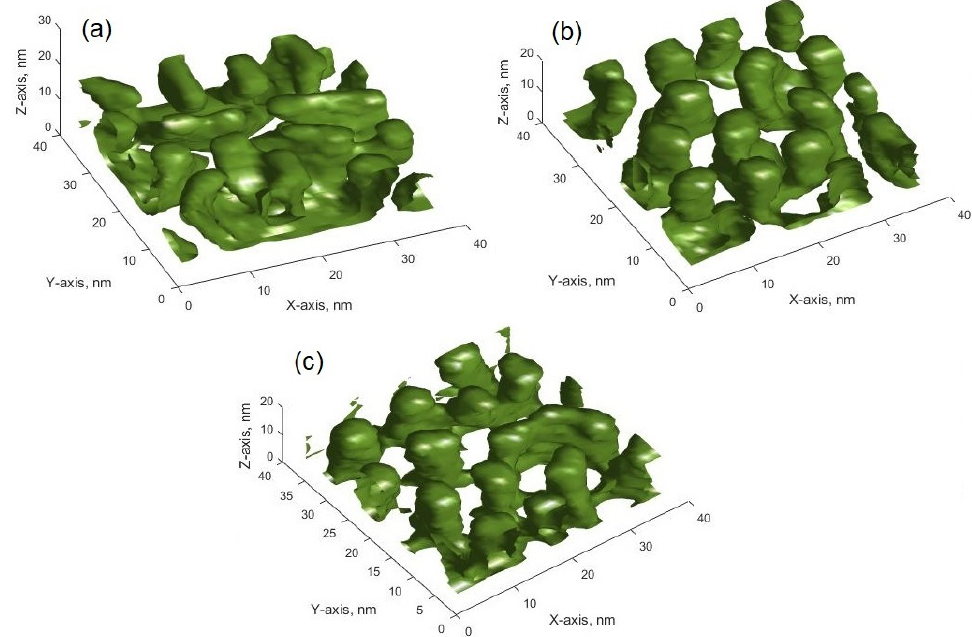
Figure 6. Three-dimensional plots of nanoclusters made of component A obtained with different diffusion coefficient D AS ; the values of D AS were as follows: D AS = 8.8 × 10 − 17 m 2 /s ( a ), D AS = 2.2 × 10 − 17 m 2 /s ( b ), and D AS = 8.8 × 10 − 19 m 2 /s ( c ). D × 10 − 17 m 2 /s ( b ), and D × 10 − 19 m 2 /s ( c AS = 2.2 AS = 8.8